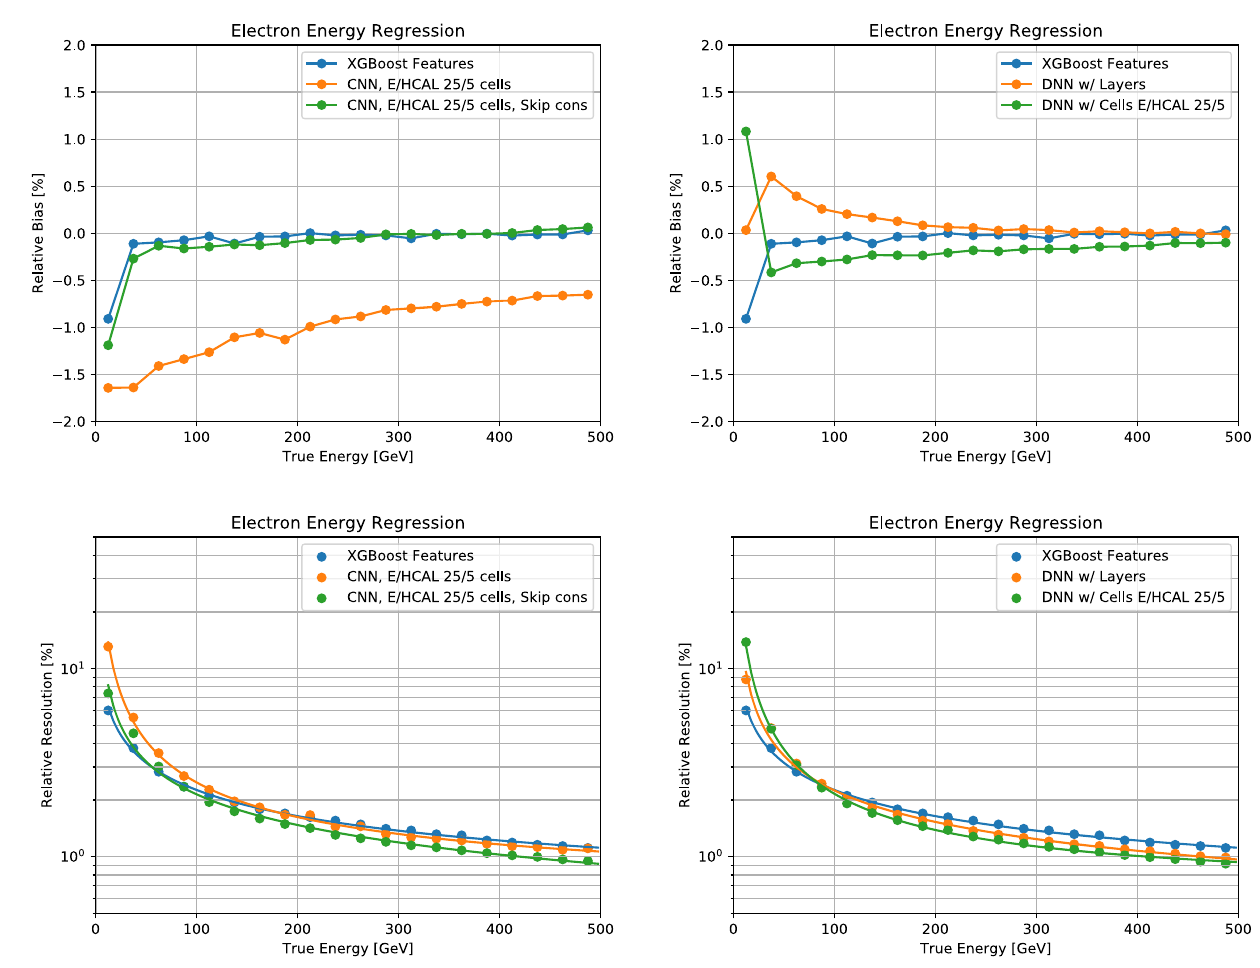
Fig. 32 Bias (top) and resolution (bottom) as a function of true energy for CNN energy predictions for electrons, with or without skip connec- tions in the architecture